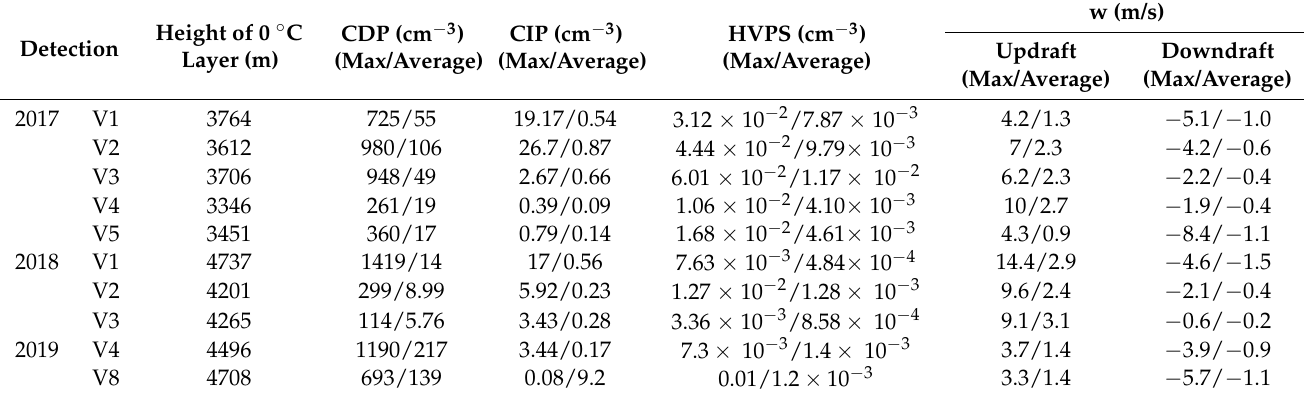
Table 3. Comparison of microphysical quantities at different